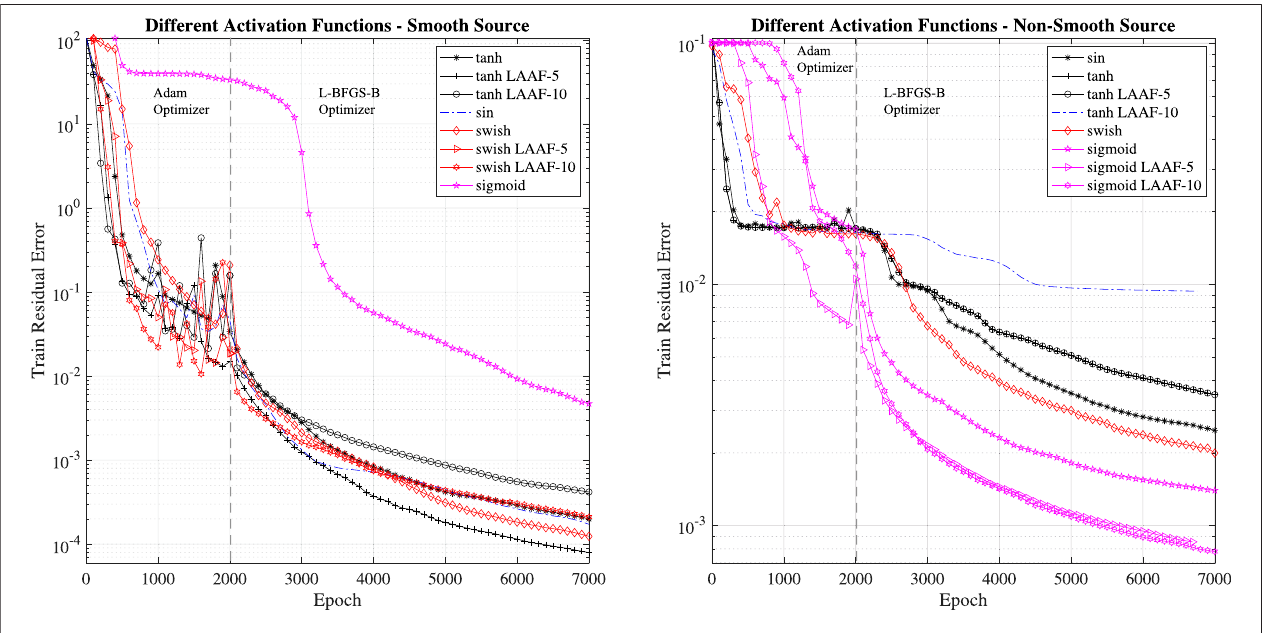
FIGURE 4 | Training error for different activation functions. The two test cases show rather different performance: the best activation function for smooth source term case is tanh, while it is sigmoid for the non-smooth source term case. Local (to the layer) adaptive activation functions provide a reduction of the training error.